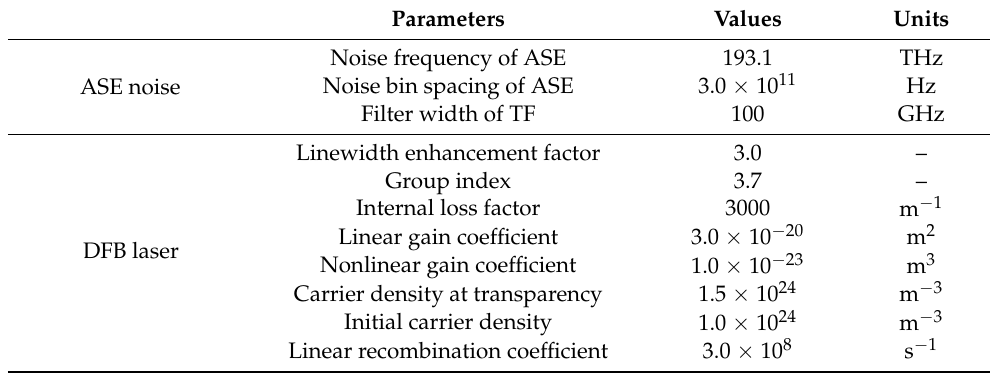
Table 1. Values of parameters used in the simulation.